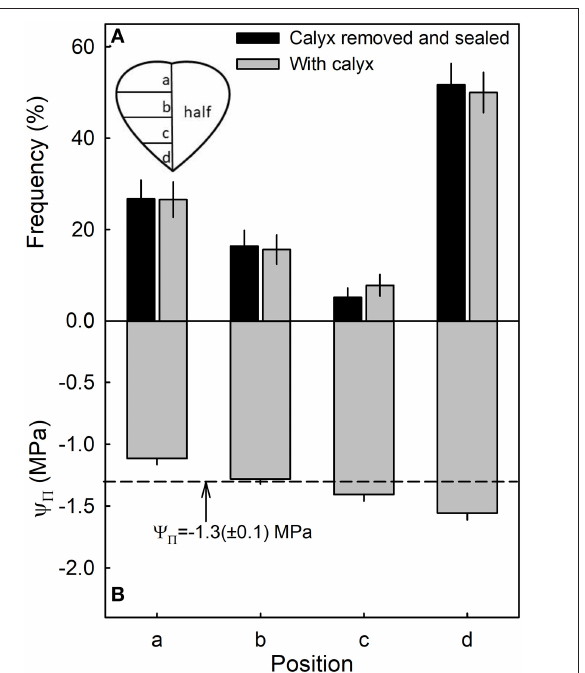
FIGURE 6 | Frequency of symptoms of water soaking (A) and the osmotic potential ( Ψ 5 ) of the juice (B) in different regions of a strawberry. The dashed line represents the mean osmotic potential of the fruit.